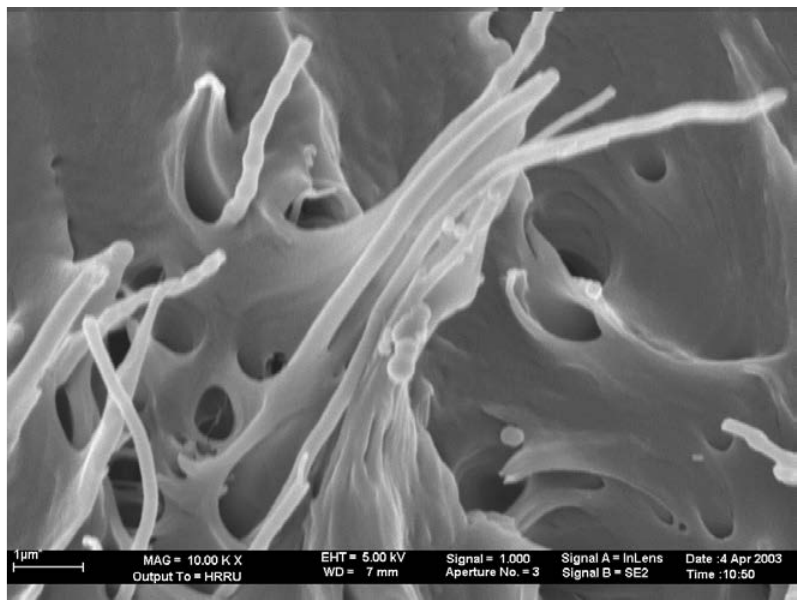
Figure 6. Syndiotactic polypropylene carbon nanofiber (CNF) composite material. The CNF has a diameter of 100 nm.